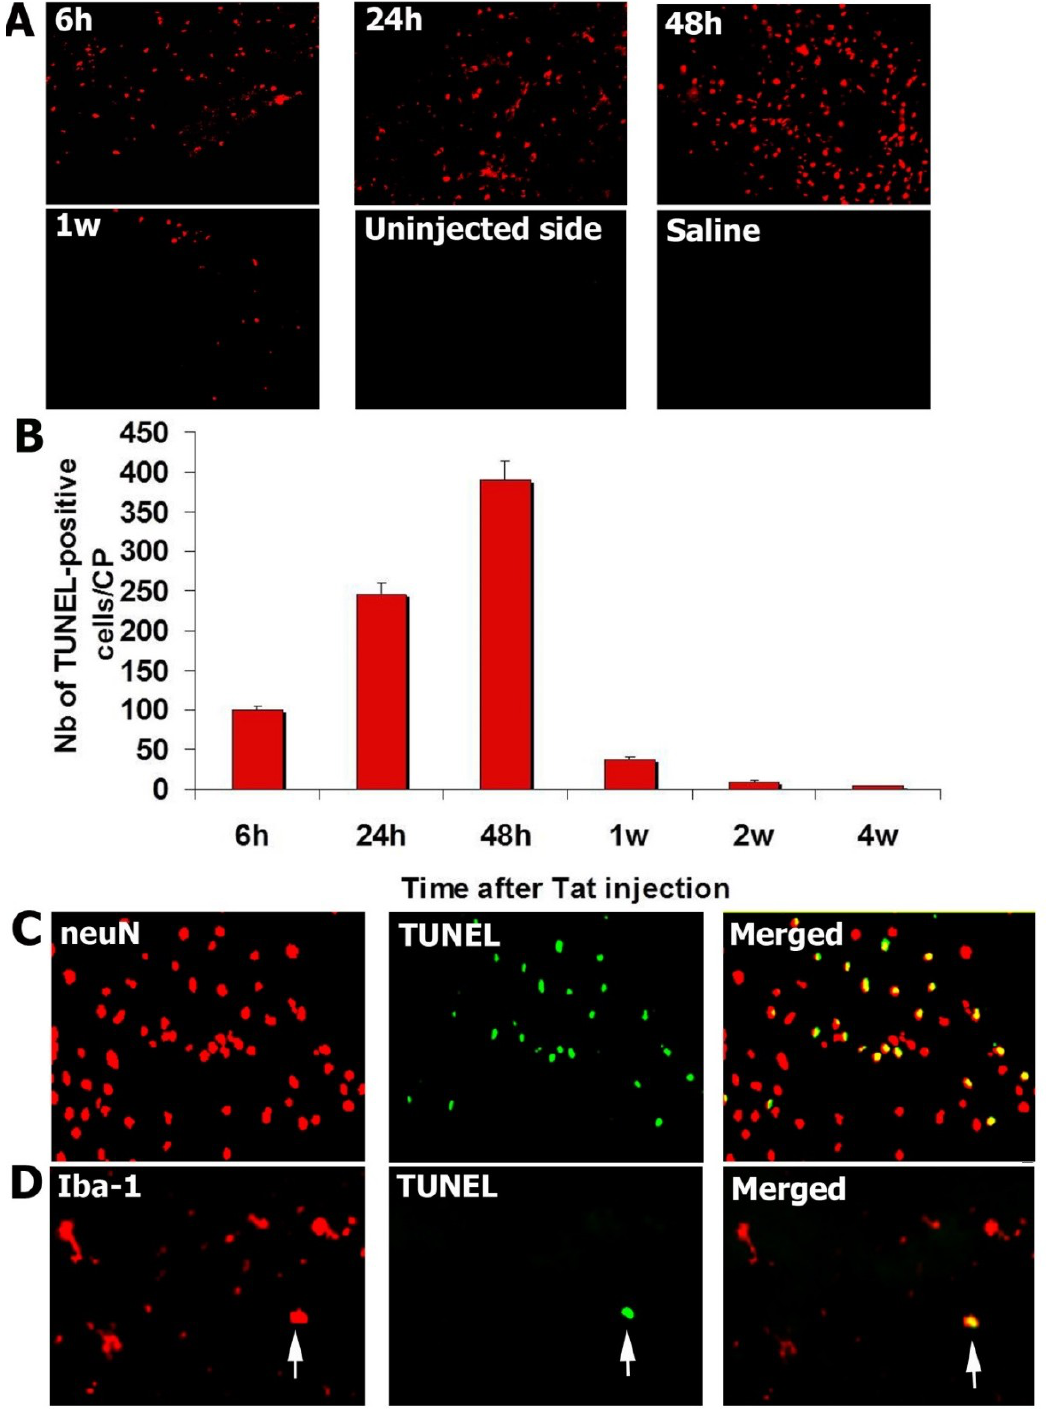
Figure 2. Tat injection in the caudate-putamen induces neuronal apoptosis. ( A ) TUNEL-positive cells were observed in the caudate-putamen (CP) after injection of Tat in the same structure. Number of TUNEL-positive cells peaked 2 days after Tat injection. No TUNEL-positive cells could be seen in CP injected with saline or in the uninjected side; ( B ) Graph showing that TUNEL-positive cells peaked 2 days after injection of Tat in CP; ( C ) TUNEL-positive cells were positive for neuN, a neuronal marker, suggesting that most of apoptotic cells were neurons; ( D ) Rare Iba-1-positive cells were TUNEL-positive